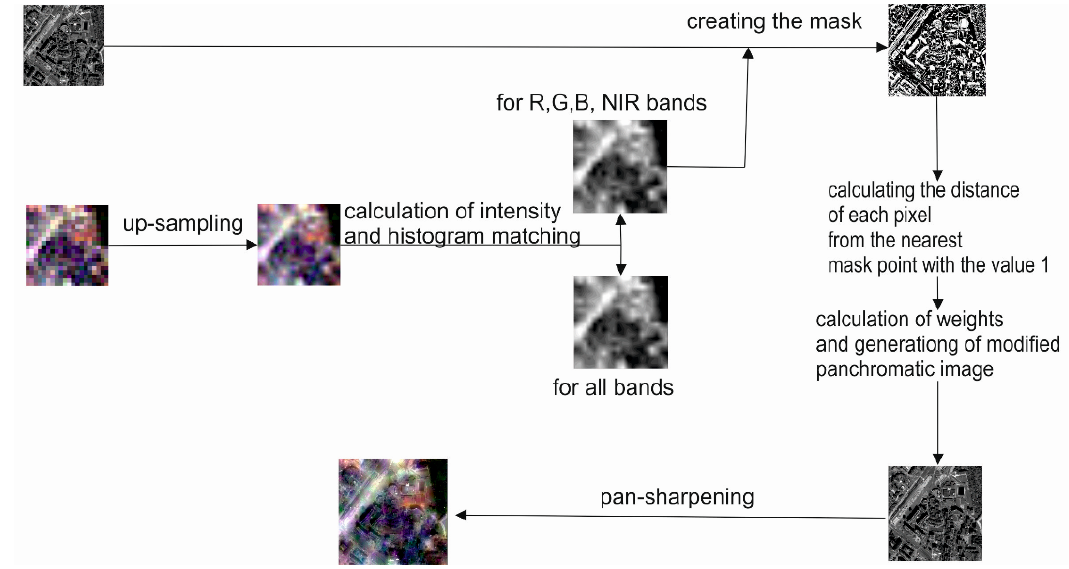
Figure 2. Diagram of the proposed pan-sharpening approach.